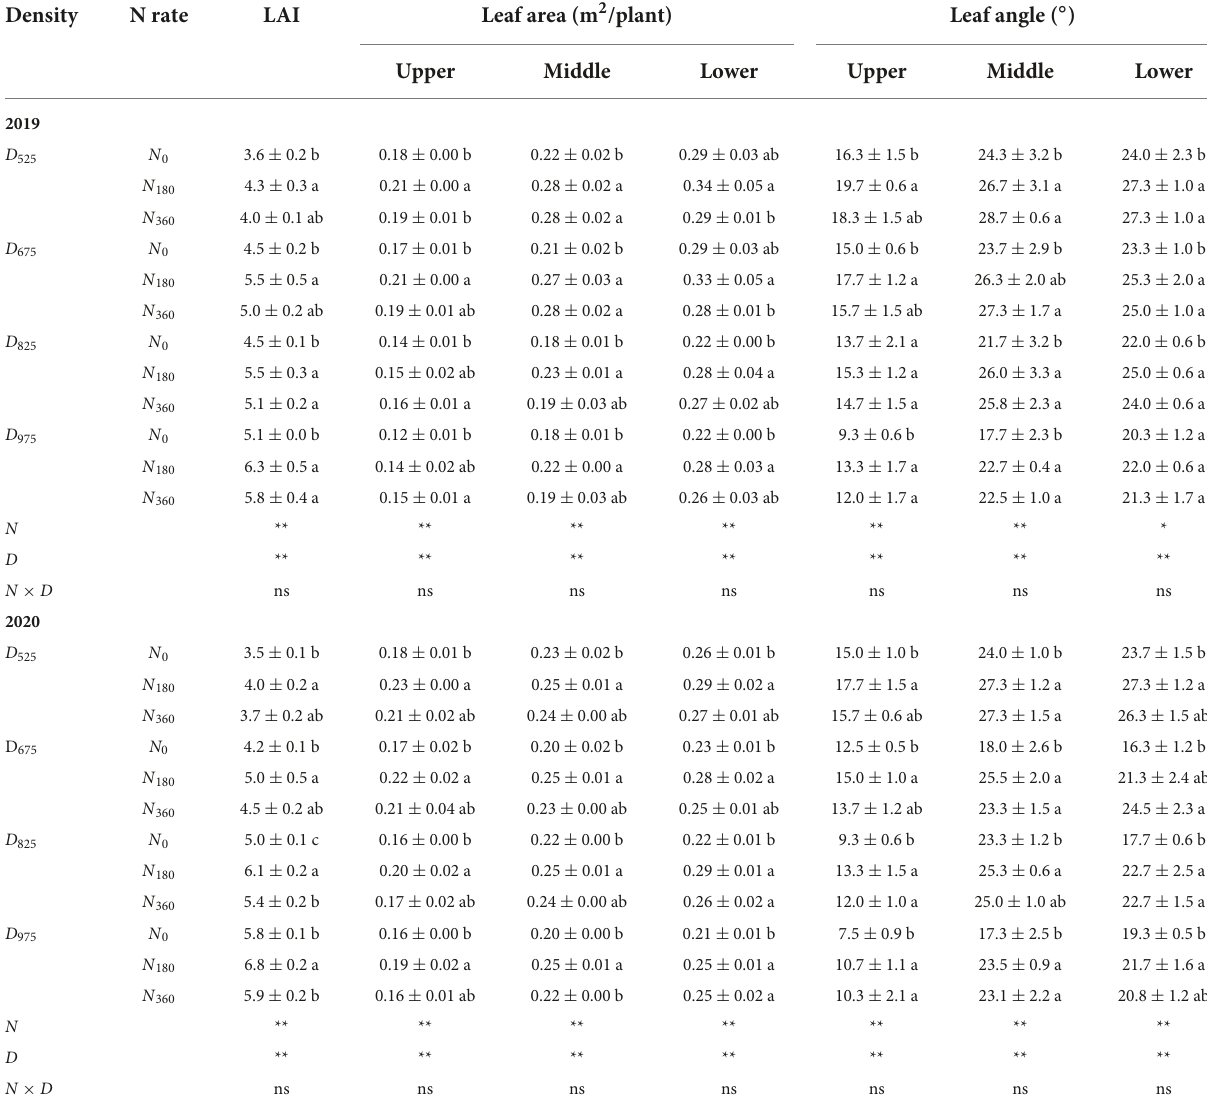
TABLE 1 Influence of N rate and plant density on the leaf area index (LAI), leaf area, and angle at different leaf positions. Density N